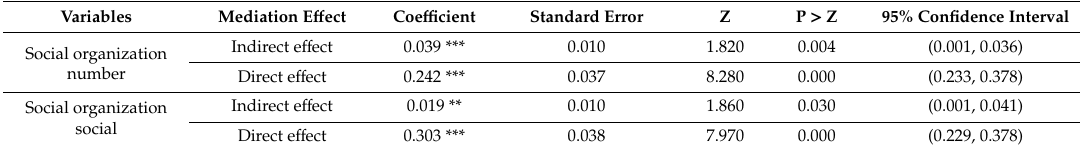
Table 12. Robustness test of the mediation e ff